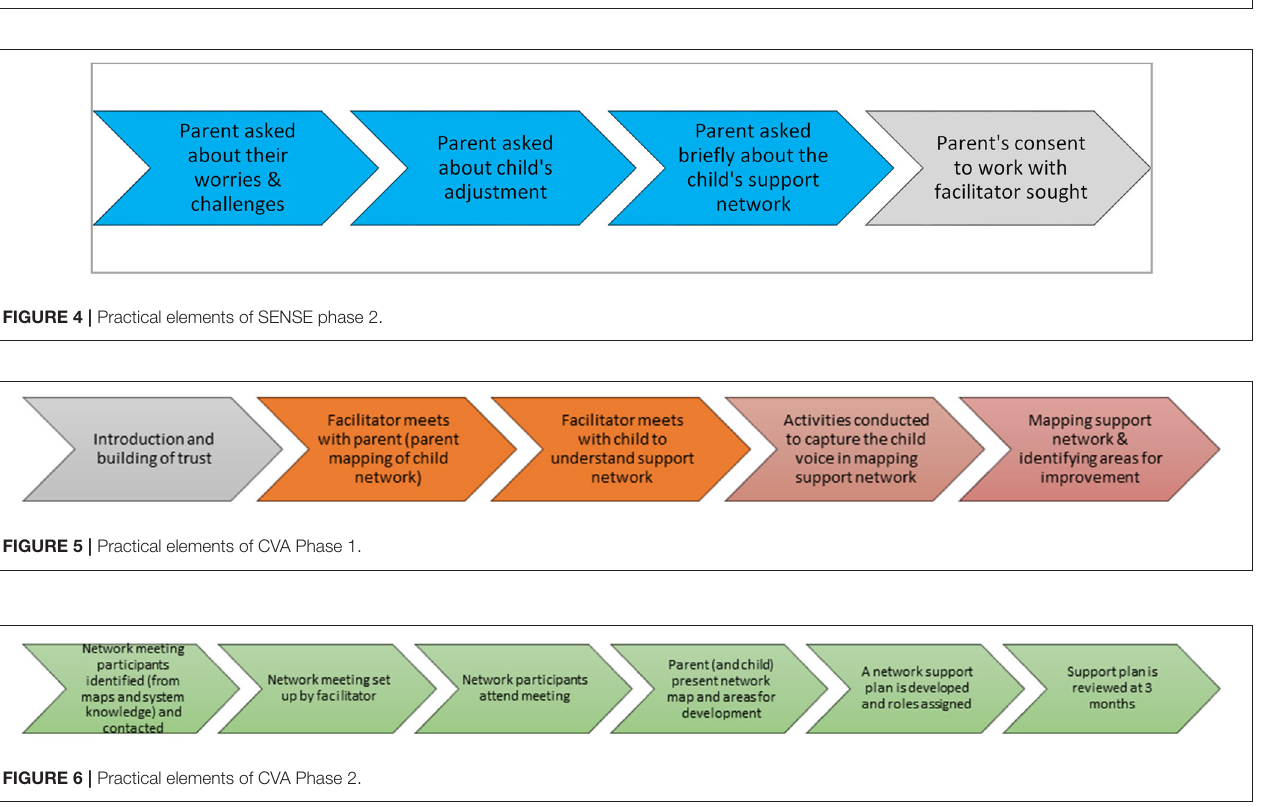
FIGURE 3 | Practical elements of SENSE phase 1.